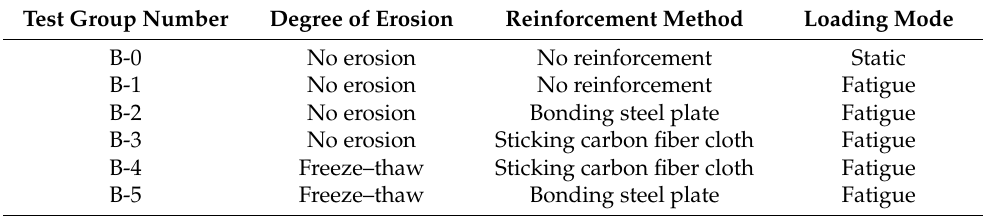
Table 2. Design of test scheme.